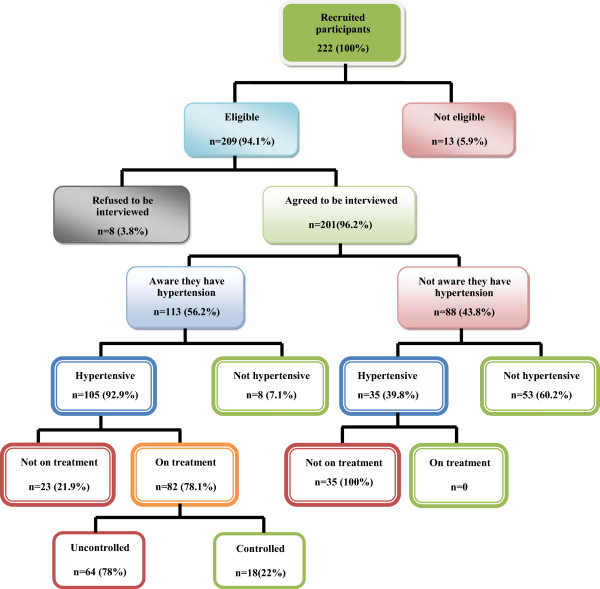
Flow chart of trends in the management of hypertension.